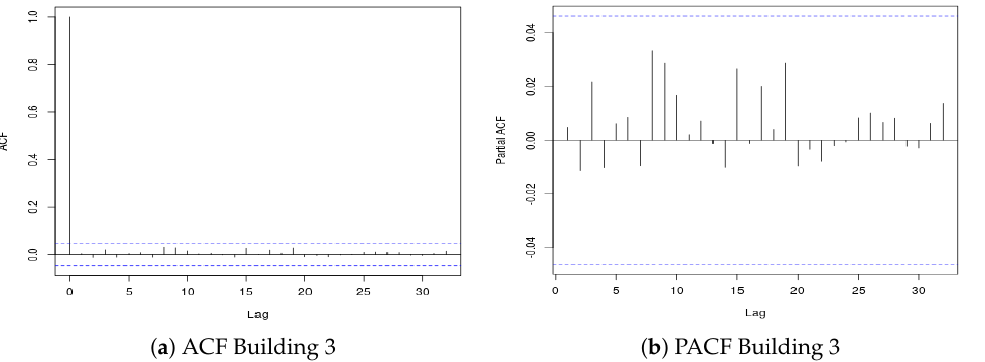
Figure 3. ACF and PACF graphs for the time series of Building